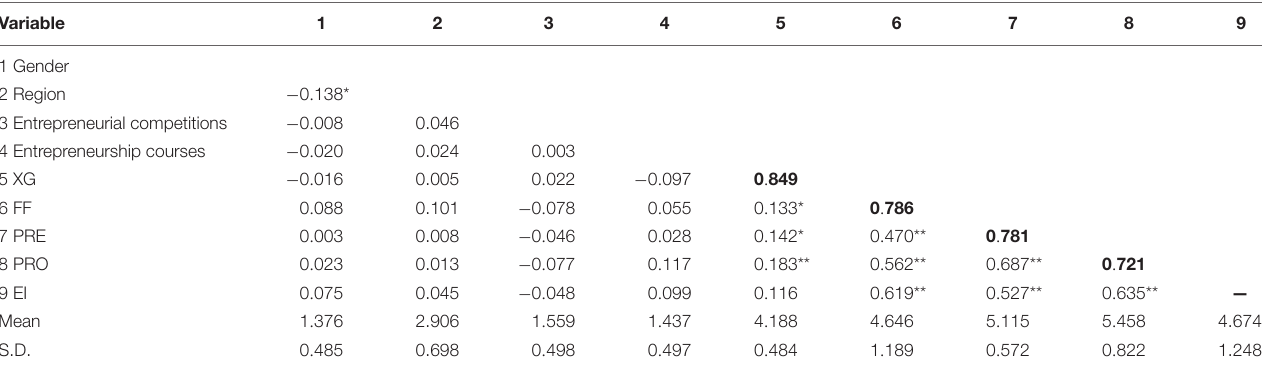
TABLE 3 | Correlations, means, and SDs.